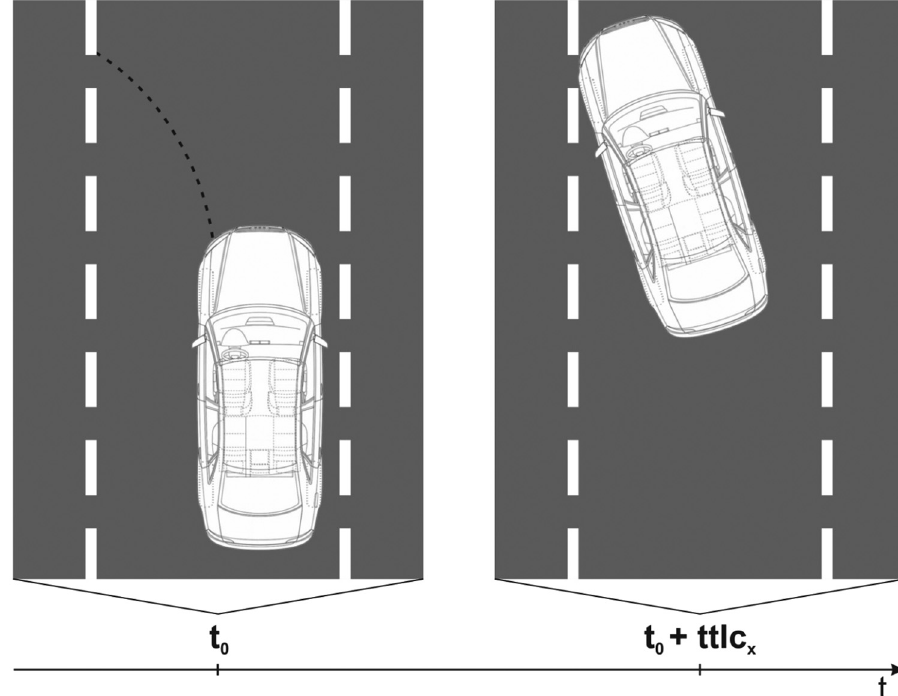
Figure 5: De fi nition of TtLC [ 12 ]